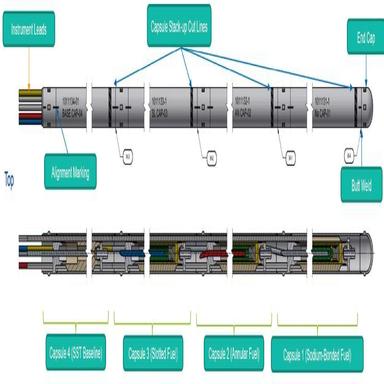
Shows a cross-section view of the IMPACT in-core test train assembly.